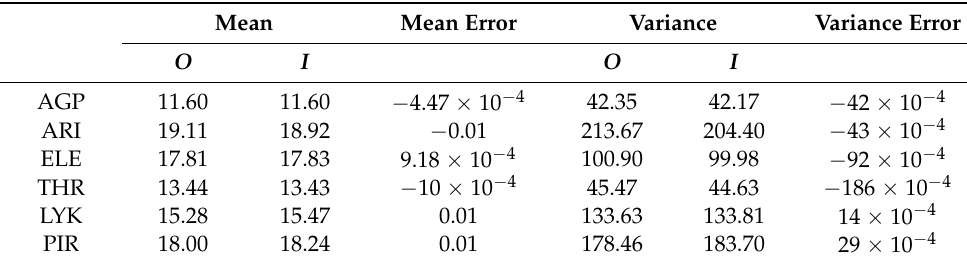
Table 8. Mean and variance values results, for the original ( O ) and the interpolated ( I ) datasets, along with the corresponding error, per monitoring station for PM 2.5 .